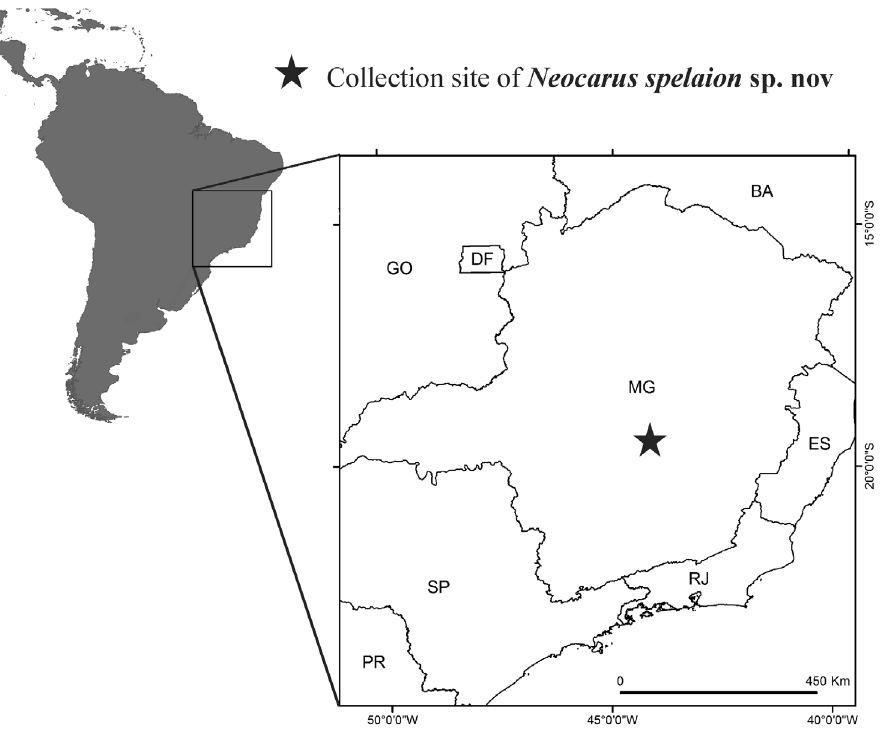
Figure 1. Collection site of Neocarus spelaion sp. n. in the State of Minas Gerais, Brazil